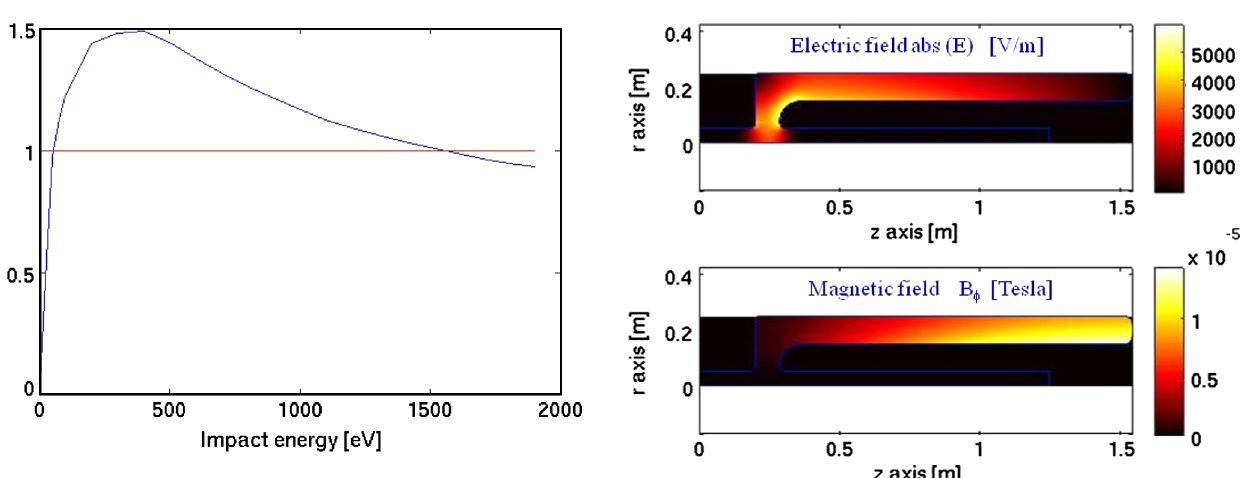
FIG. 2. (Color) Secondary yield for niobium as a function of the electron impact energy in eV.